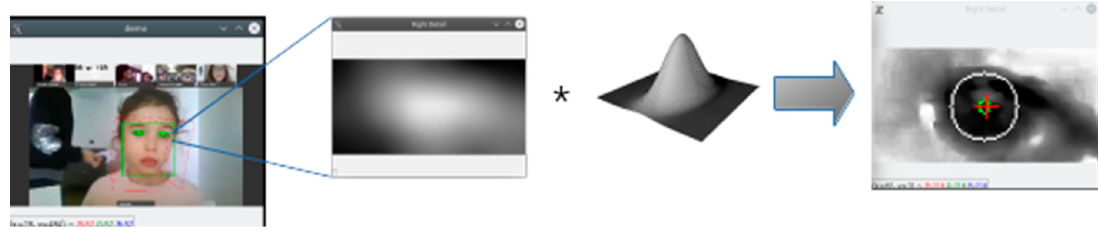
Figure 4. The eye-gaze tracking process pipeline.